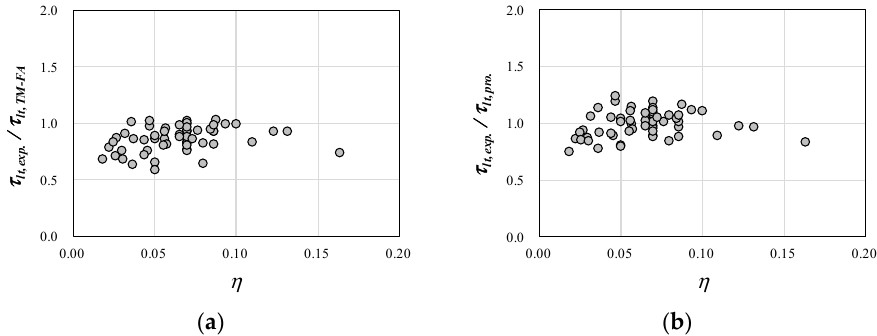
η : ( a ) TM-FA; ( b ) proposed model.